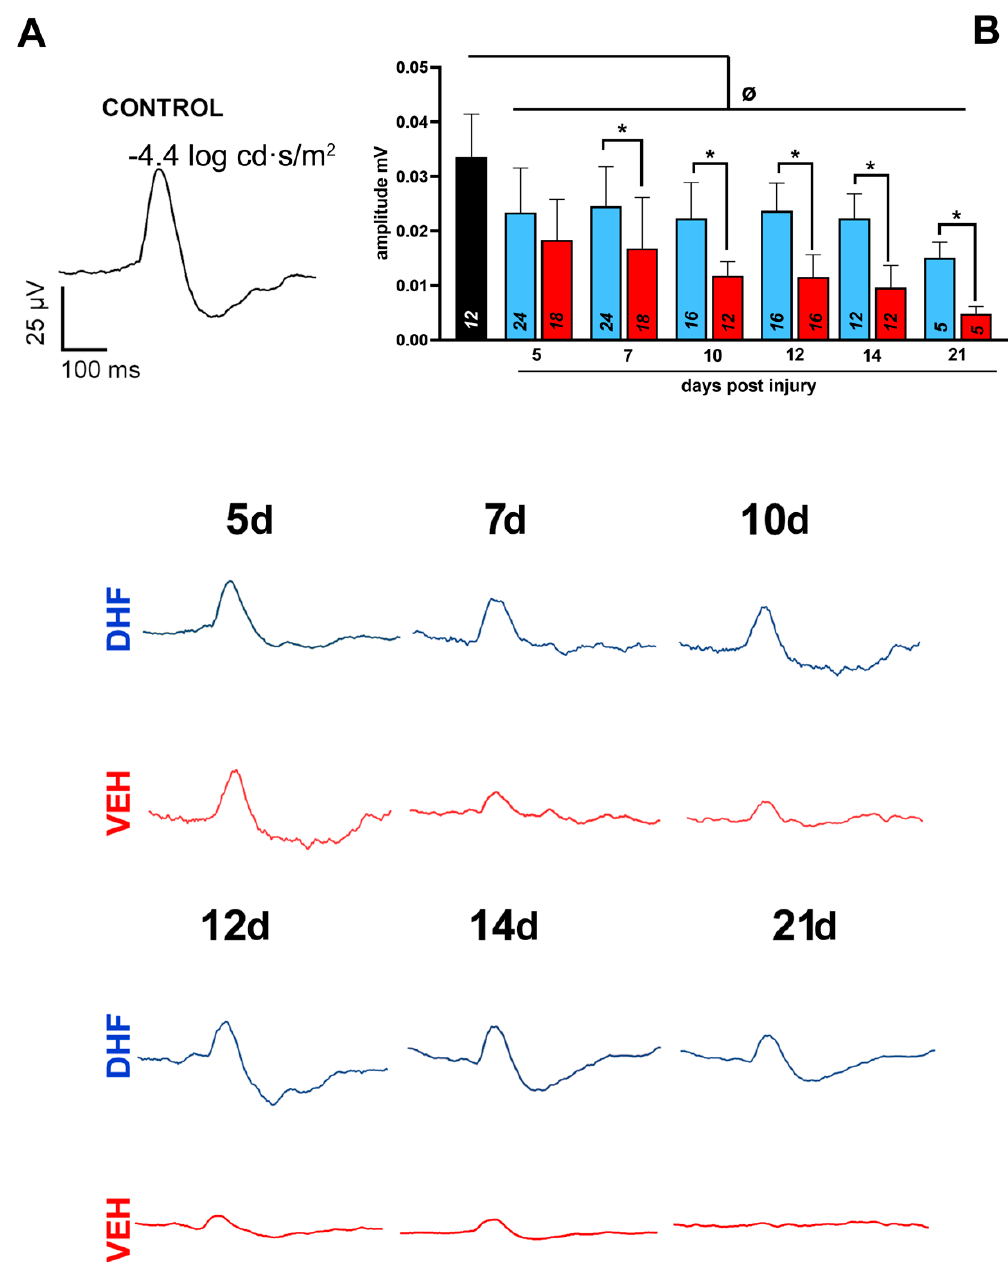
Figure 1. Treatment with 7,8-Dihydroxiflavone attenuates axotomy-induced RGC function loss. Adult albino rats were treated daily with i.p. vehicle (VEH) (1% DMSO in 0.9% NaCl) or DHF (5 mg/kg) starting the day before left optic nerve section. STR was recorded longitudinally in both eyes at days 5, 7, 10, 12, 14, and 21 after axotomy with a stimulus intensity of − 4.4 log cd s/m 2 . ( A ) Representative traces of the STR recordings at different time intervals. Representative traces from a control (in black) or experimental retinas treated with DHF (in blue) or Vehicle (in red). ( B ) Bar histogram showing mean (± SD) amplitudes in millivolts of the control (in black, n = 12) and experimental groups treated with DHF (in blue) or VEH (in red) analyzed longitudinally at increasing survival intervals ( n for each experimental group analyzed at different days post injury are indicated in the corresponding bar of the histogram). Differences between Control and DHF 7 d ( p = 0.027); Differences between DHF 7 d and DHF 21 d ( p = 0.0006 One-way ANOVA). One-way ANOVA * p < 0.05, differences between DHF and VEH treated group. One-way ANOVA Ø p < 0.05, differences between Control and the experimental groups.